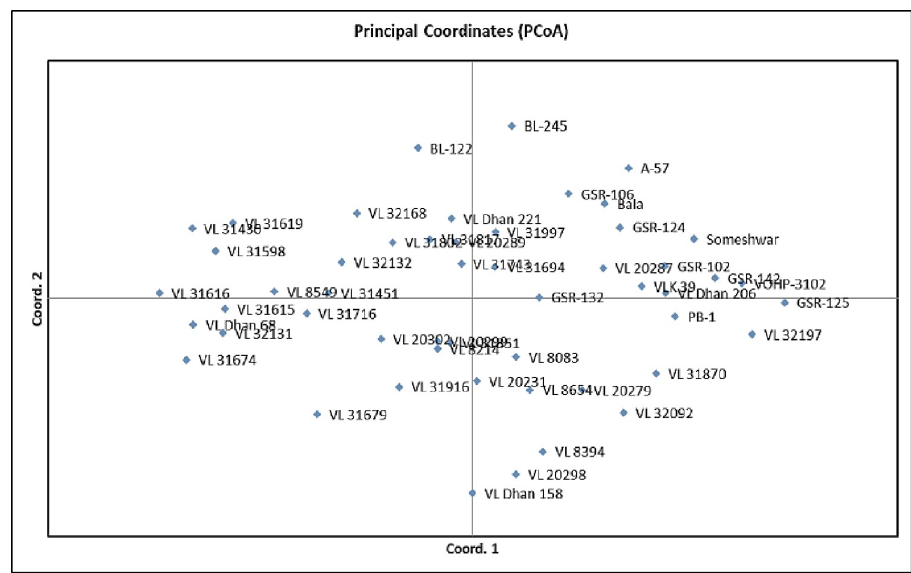
Fig 3. PCoA of 25 molecular markers linked to blast resistance in 52 rice genotypes.